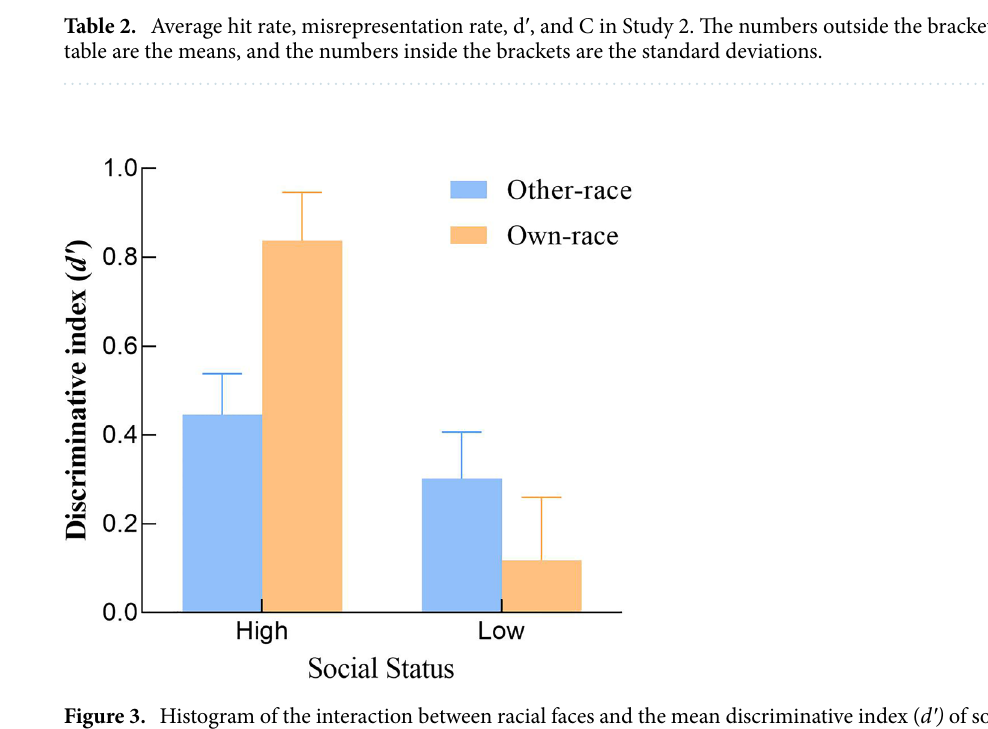
Figure 3. Histogram of the interaction between racial faces and the mean discriminative index ( d ′ ) of social status in Study 2. Error bars: ±